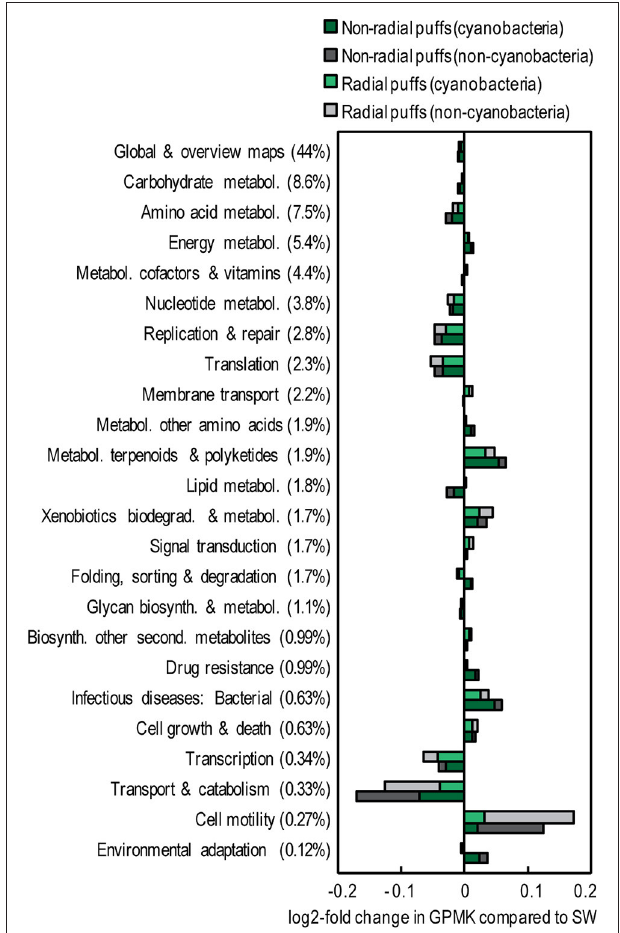
FIGURE 6 | Relative abundance of KEGG gene groups in Trichodesmium colony samples (collected 23 Mar 2014) compared to a surface seawater sample from Stn. ALOHA (collected 30 July 2015). The percentages of total counts within each gene group are provided in parentheses. Colors represent sample type and taxonomic assignment. Pathways involved with organ systems, human disease, and/or representing < 0.1% of total GPMK were excluded. Pathways displayed represent > 97% of total